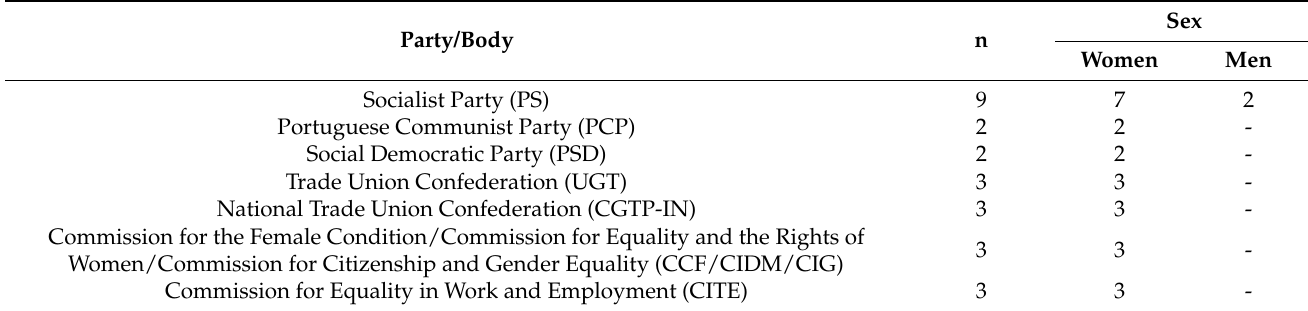
Table 2. Interviewees by gender and current or past membership of political parties and/or